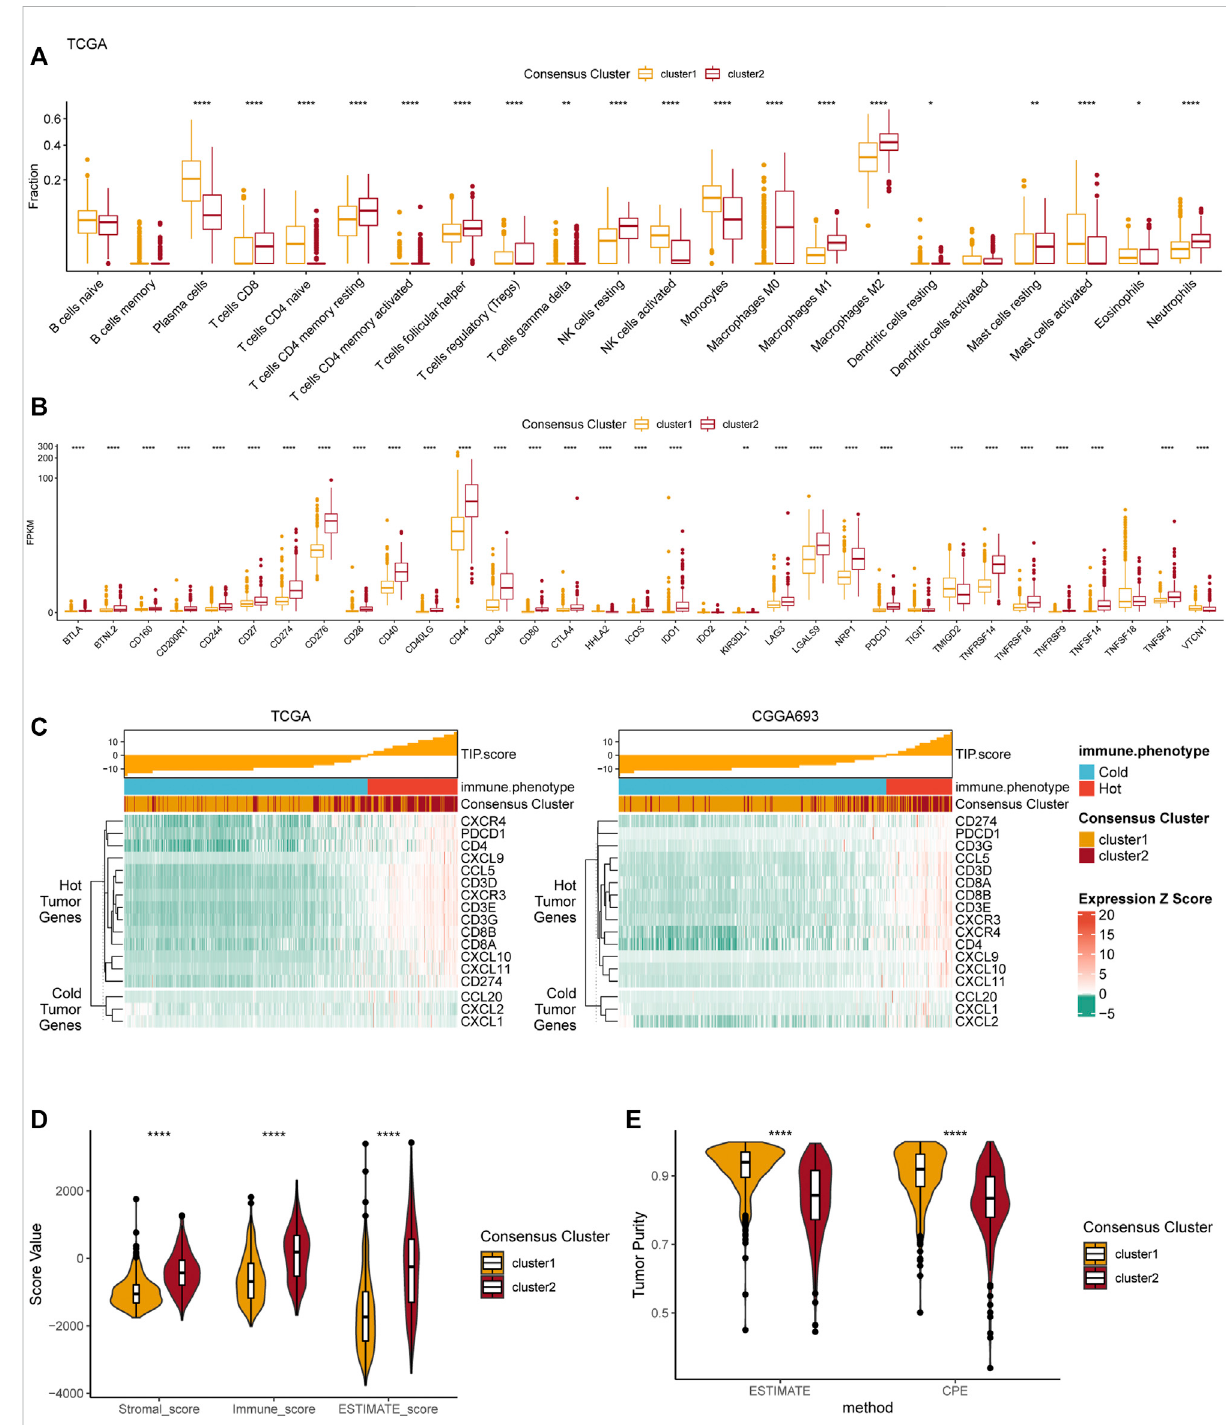
FIGURE 4 Differences in immune features of tumor microenvironment between two clusters. (A) Boxplot of the estimated fraction of 22 immune cells in tumors. (B) The expression level of 33 immunotherapy-related genes in each consensus cluster. (C) TIP scores and related gene expression levels between two clusters in TCGA and CGGA datasets. (D) Stromal, immune, and ESTIMATE scores of the consensus clusters. (E) Tumor purity is calculated by the ESTIMATE and CPE algorithms. * p < 0.05; ** p < 0.01; *** p < 0.001; **** p <